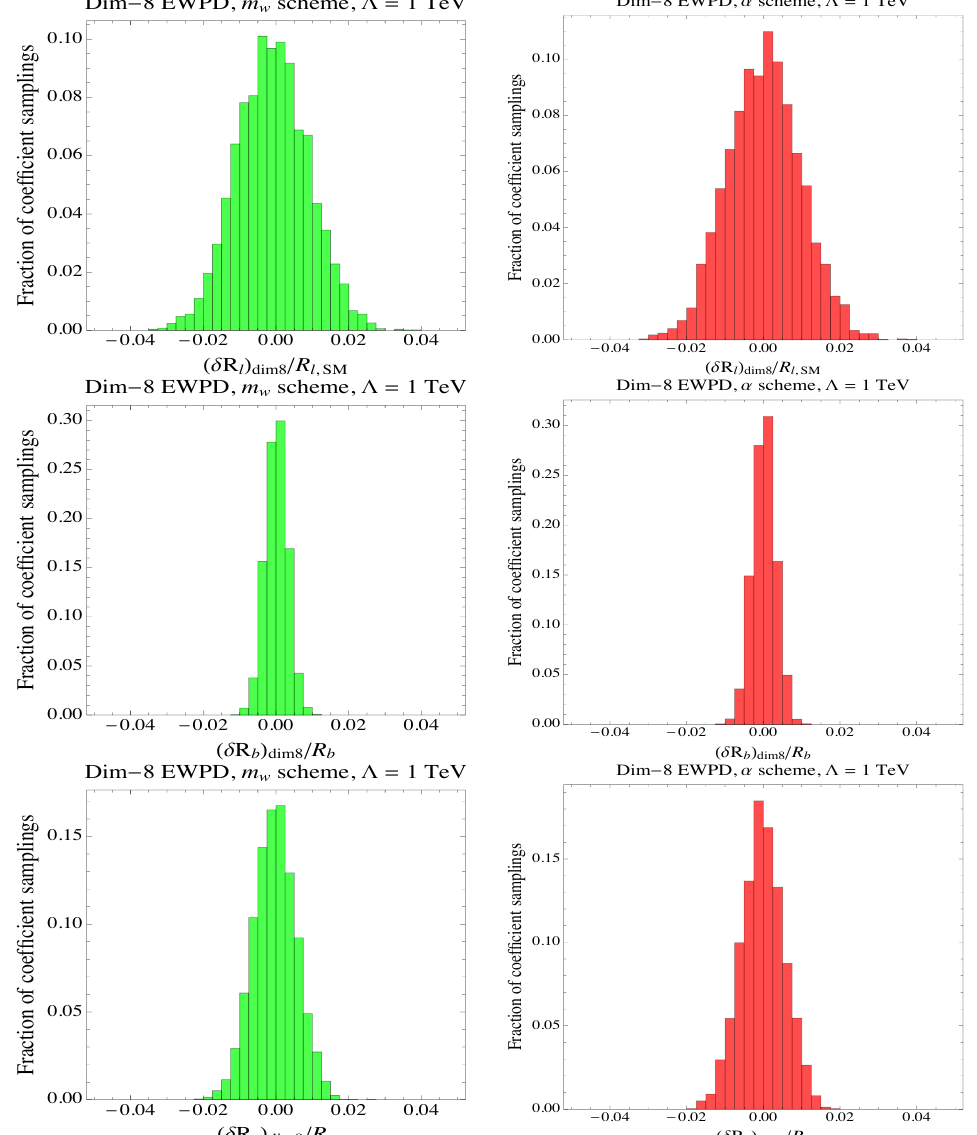
Figure 1 . Contributions to the R ‘ , R b and R c EWPD from L (8) operators relative to the SM value. Here Λ = 1 TeV. The histograms are formed by selecting random values for the coefficients 5000 times following the scheme described in the